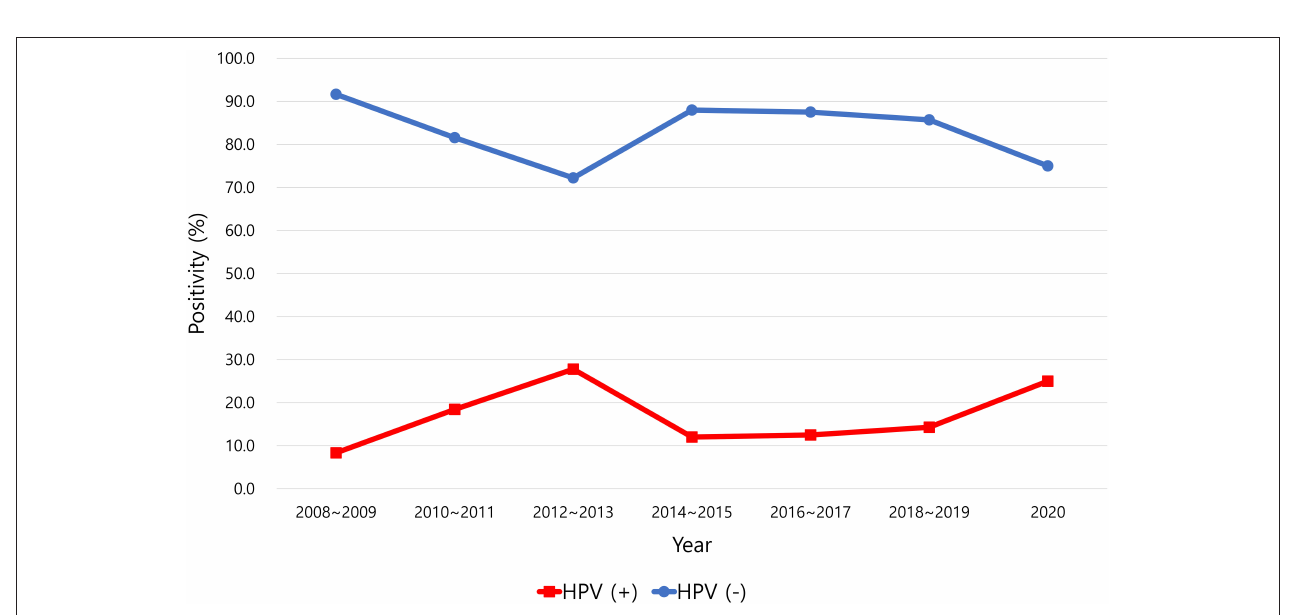
FIGURE 2 | Positive rate of human papillomavirus (HPV) in squamous cell carcinoma of the oral cavity, larynx, hypopharynx, and sinonasal cavity.